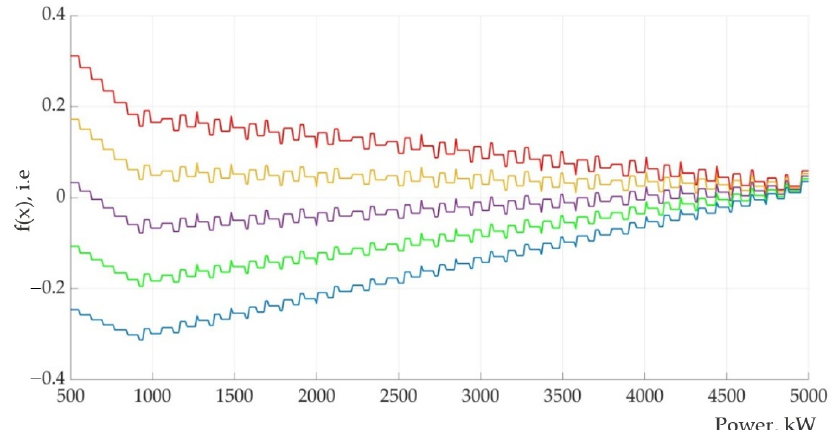
Figure 6. Dependence of the objective function on power (the red line is the objective function with coefficients { 0,0;0,8;0,2 } ; the yellow line is the objective function with coefficients { 0,2;0,6;0,2 } ;